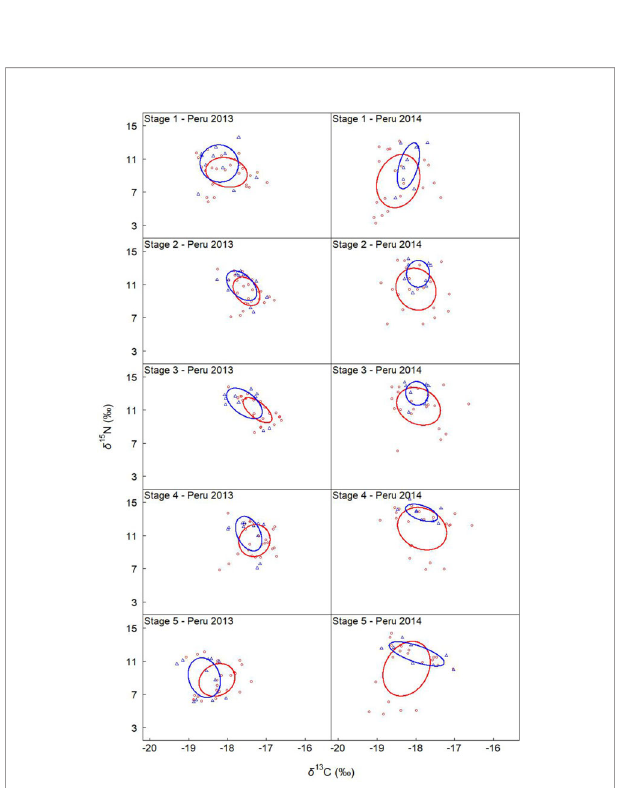
FIGURE 5 | Sexual variation in the isotopic niche off Peru in 2013 and 2014. Solid lines enclose the standard ellipse areas (SEAc), showing the isotopic niche of females and males (red and blue represent female and male, respectively). “ Peru 2013 ” represents the samples collected off Peru during 2013, and so